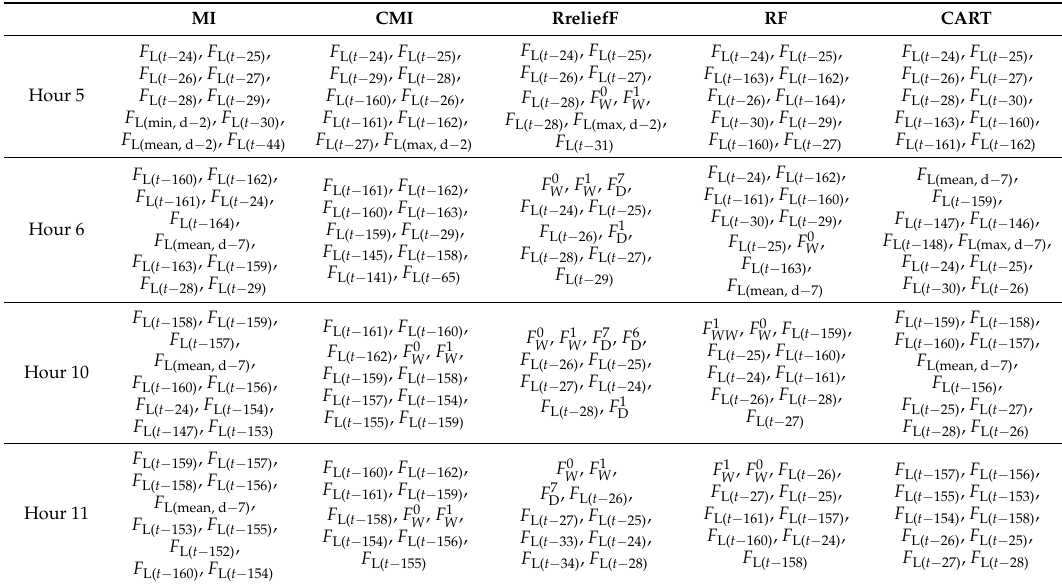
Table 3. Top 10 features of ranked of feature by different feature selection corresponding to Figure 3.